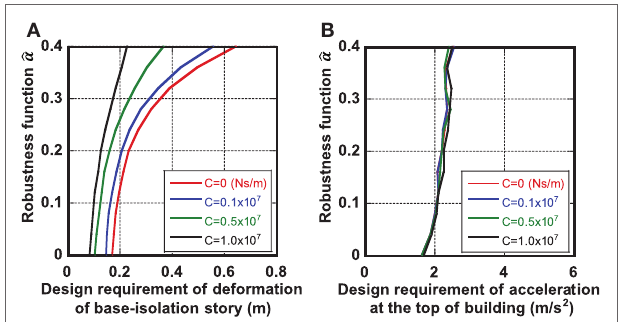
FIGURE 11 | Robustness function with respect to design requirement, (A) deformation of the base-isolation story and (B) absolute acceleration at the top of the main structure (Osaka area).